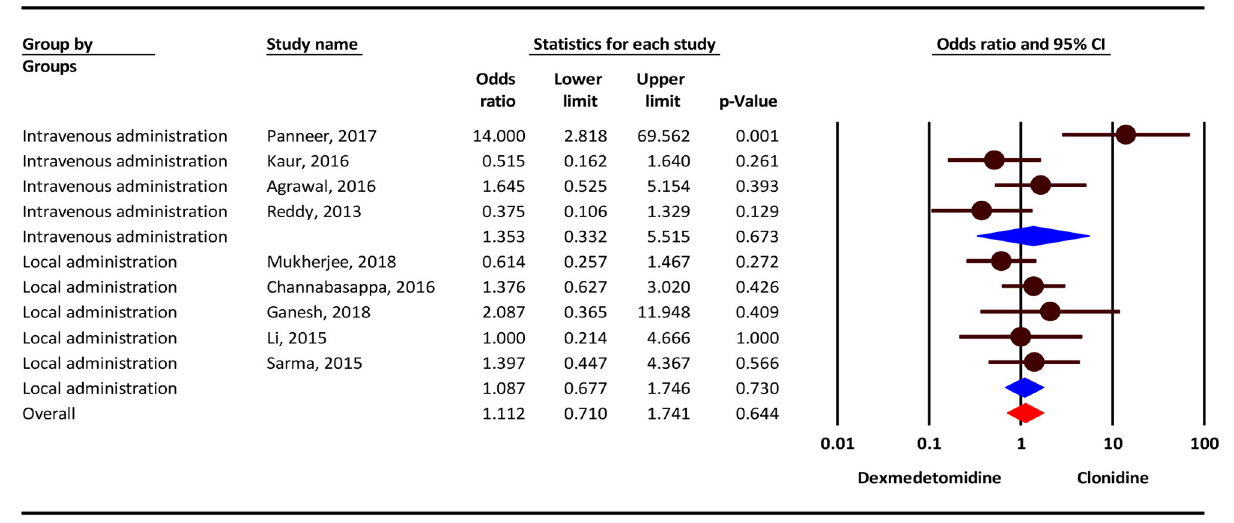
FIGURE 2 | The odds ratio for the risk of Bradycardia/Hypotension as an adverse event associated with the adjuvant use of dexmedetomidine and clonidine in intravenous and local